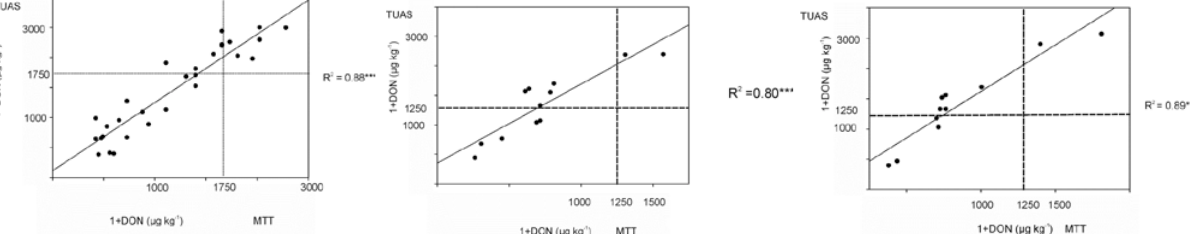
Figure 3. Correlations between log deoxynivalenol (DON) concentrations in Finnish oat (a), barley (b) and wheat (c) grain samples in 2013, estimated using the RIDA® QUICK SCAN compared with to log DON concentrations obtained at MTT by using GC-MS. The samples were ground using the same mill at MTT for DON estimation, with sieving. Regression slopes and R2 (coefficient of determination) values are shown. *** indicates statistically significant ( P <0.001).